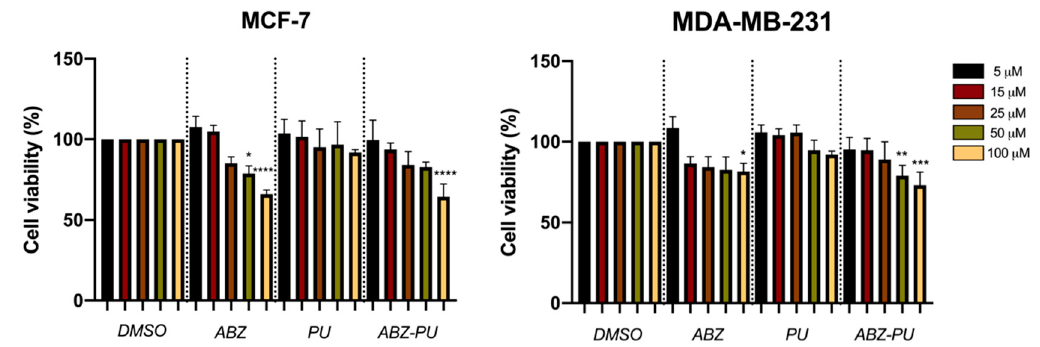
Figure 10. The viability percentage of MCF-7 and MDA-MB-231 cells 24 h post-treatment with test compounds (ABZ, PU and ABZ-PU) at different concentrations (5, 15, 25, 50 and 100 µM). Cell viability was normalized at corresponding concentrations of DMSO-treated cells. (Statistical significance: *: p < 0.05, **: p < 0.01, ***: p < 0.001 and ****: p < 0.0001).